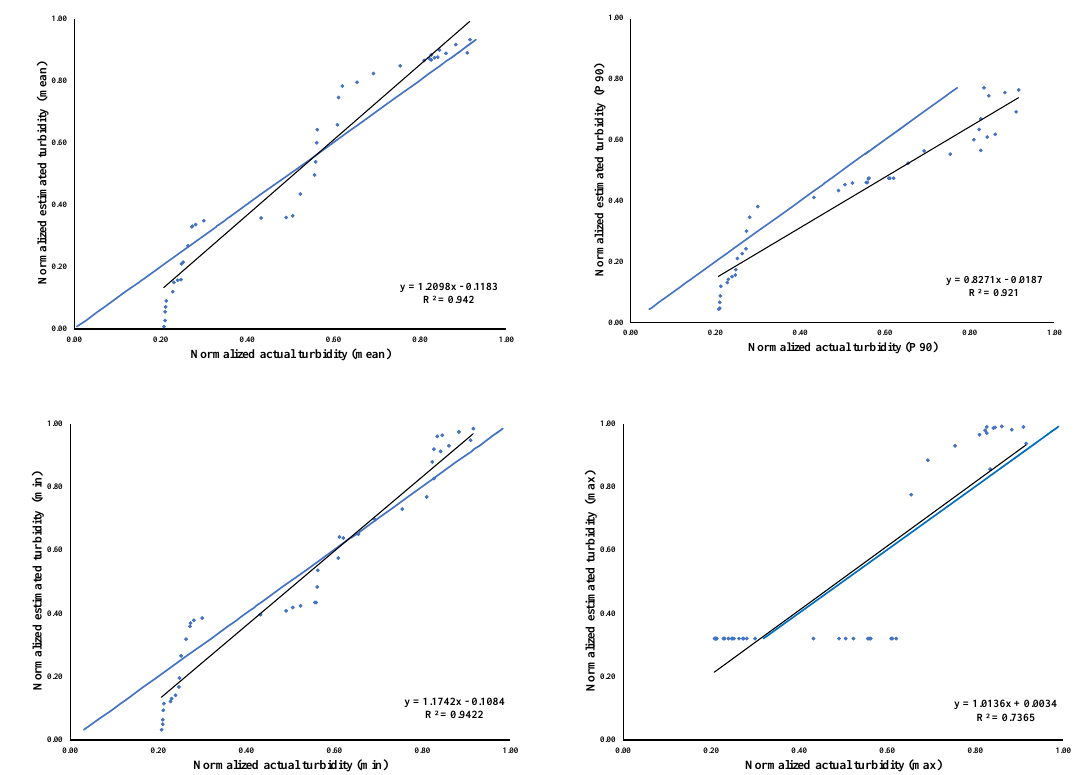
Figure 4. Normalized difference turbidity index (NDTI) regression analysis with respect to different zonal statistics values.